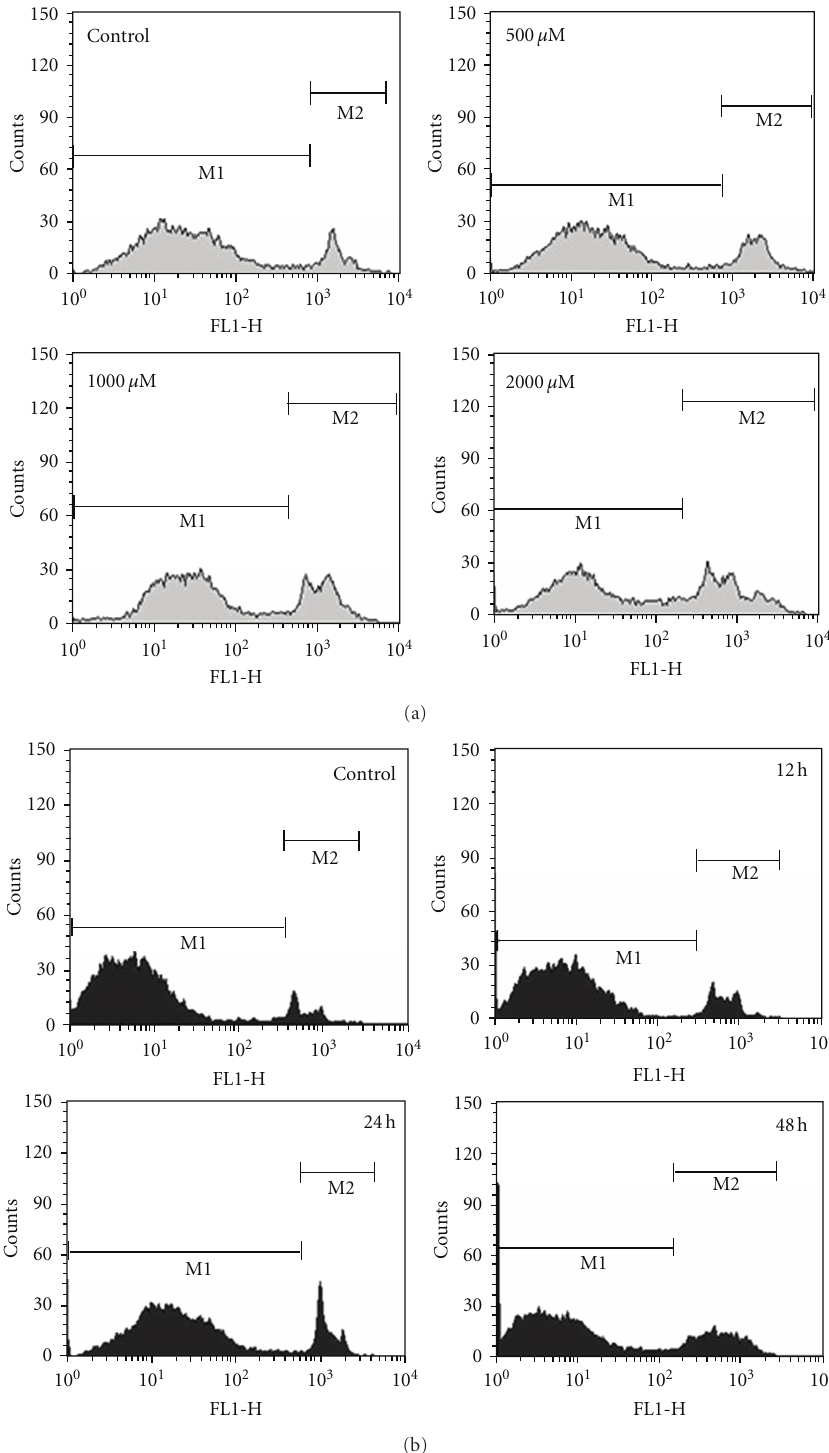
Figure 4: Apoptosis evaluation using Yo-Pro-1 dye by flow cytometry. (a) HCT 15 cells were treated with di ff erent doses of ca ff eic acid for 48h. The distribution of cell population changed according to the doses as indicated by M1 and M2. Percentage of M2 population depicting apoptosis increased depending upon the increasing dose. Data is representative of three independent experiments. (b) HCT 15 cells were treated with ca ff eic acid for specified time points. The distribution of cell population changed according to the exposure time as indicated by M1 and M2. Percentage of M2 population depicting apoptosis increased on the basis of the duration of treatment. Data is representative of three independent